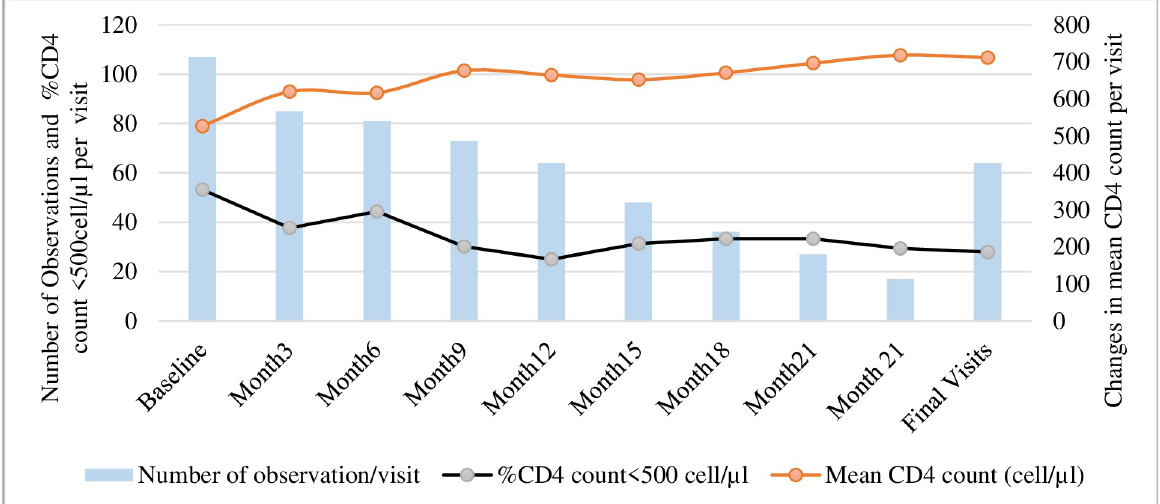
Fig 1. Time trends in mean CD4 and proportions of CD4 < 500 among HIV-infected FSWs on ART, Benin. N: Number of observations per visit %CD4 count < 500 cell/ μ l: Proportion of participants with CD4 < 500 cell/ μ l during follow up Mean CD4 count: Changes in mean CD4 count during follow up Final visits: Included 63 participants who had final visits from Month 3 onwards and one early final that occurred at Month 3. Subjects with final visits at Day 14 (one at the end of the study for a seroconverting participant from the PrEP component of the study and two early final visits because of active withdrawal) were excluded from this